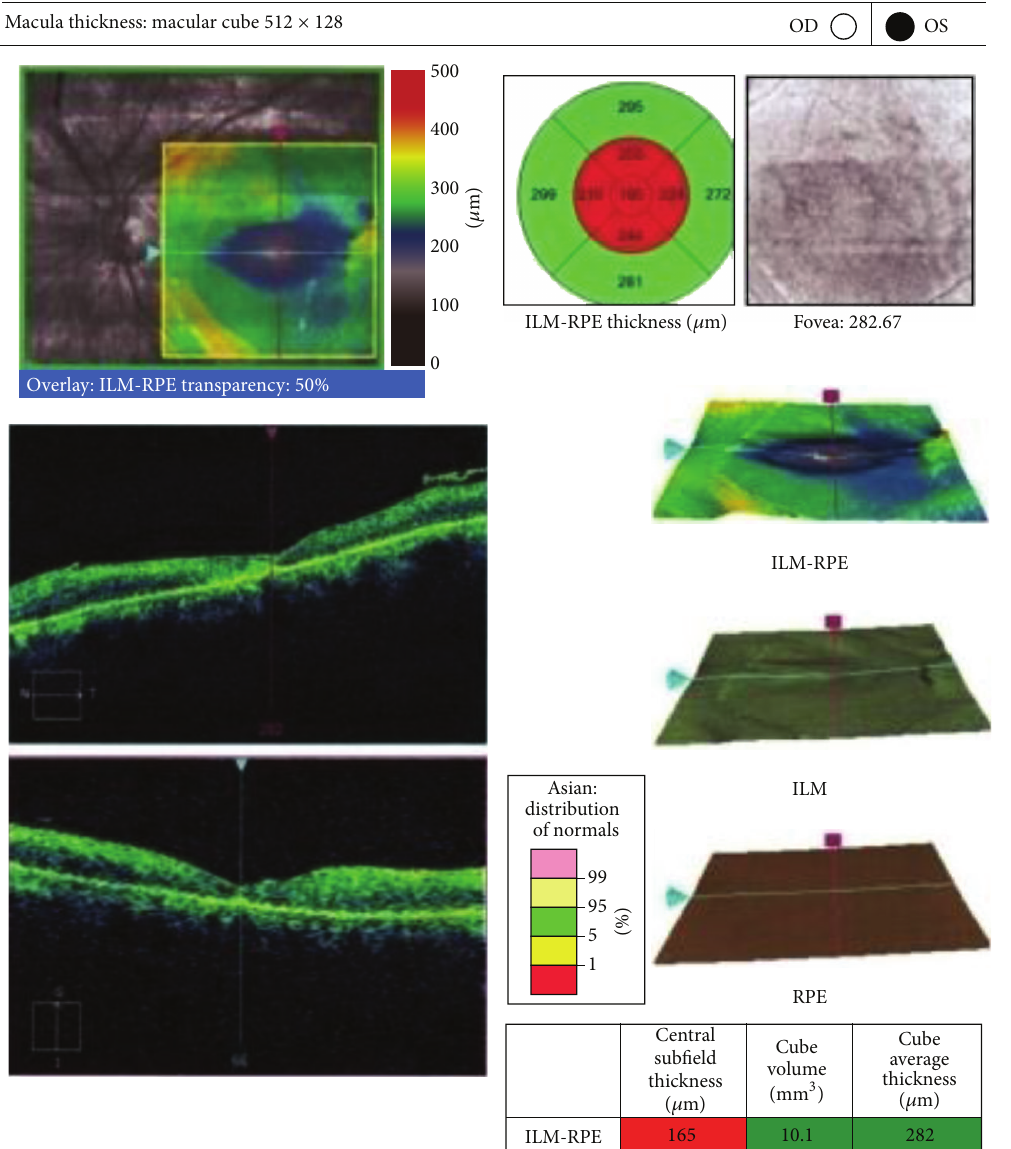
Figure 9: Hyperdense and adherent RPE and retinal